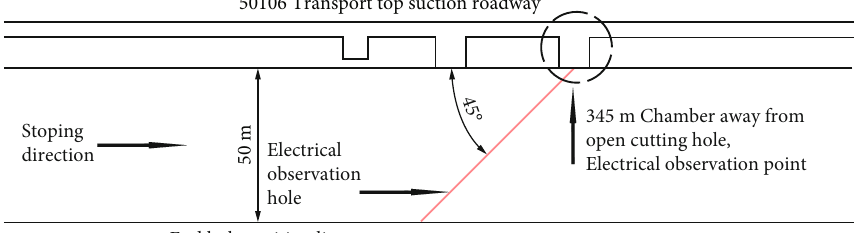
Figure 7: Diagram of detection